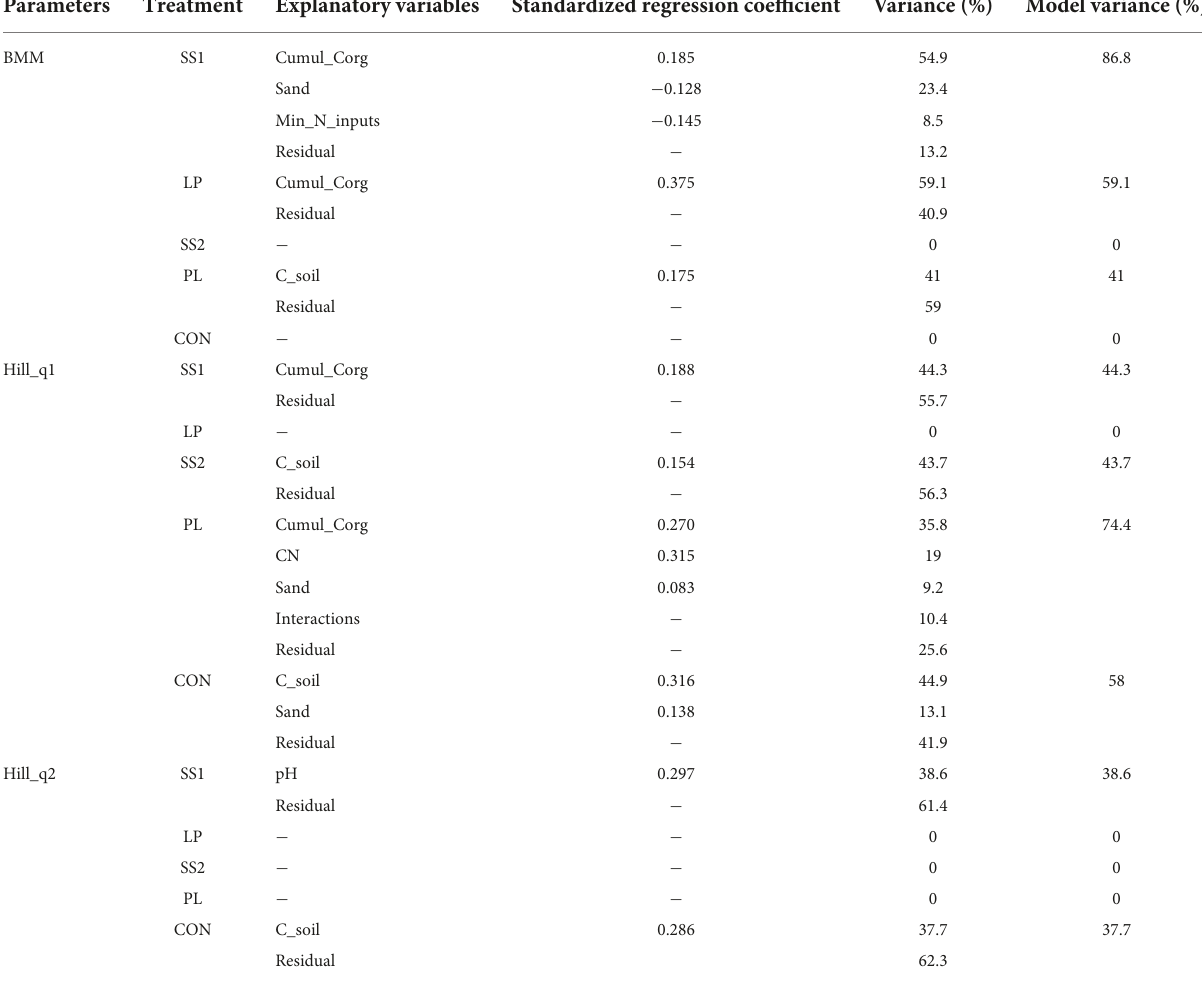
TABLE 2 Effects of environmental conditions on the soil molecular microbial biomass (BMM) and the bacterial—archaeal diversity indices (Hill number with an order 1 and 2) of soils from La Mare (Reunion Island) according to the fertilizer input (CON, inorganic fertilized control; SS1 and SS2, sewage sludge inputs; LP, liquid pig manure; PL, poultry